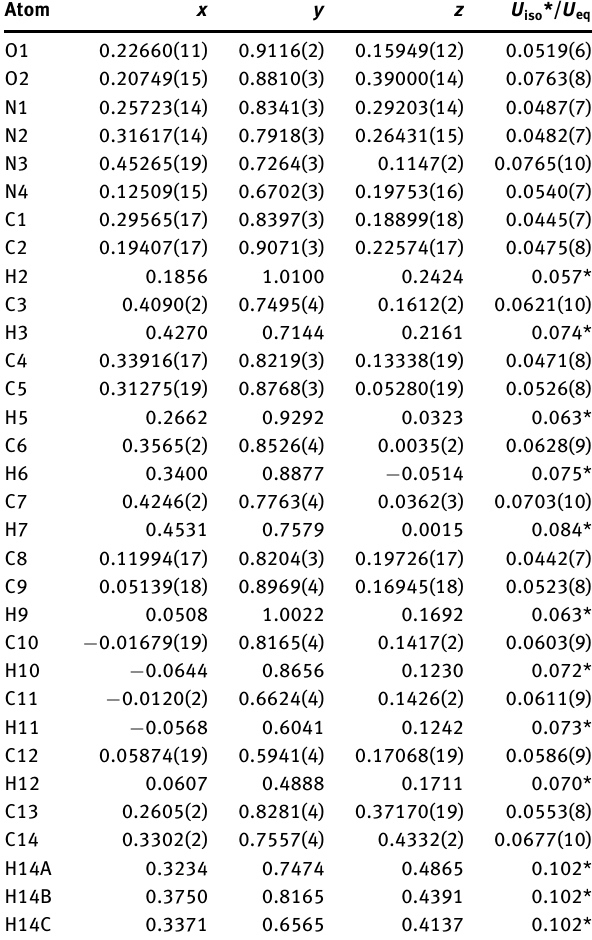
Table 2: Fractional atomic coordinates and isotropic or equivalent isotropic displacement parameters (Å 2